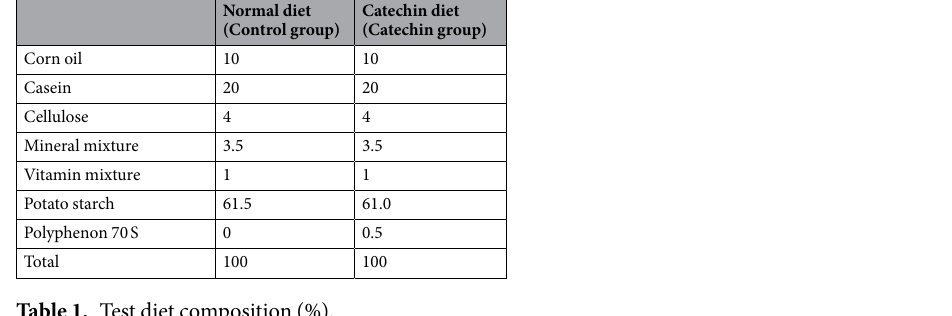
Table 1. Test diet composition